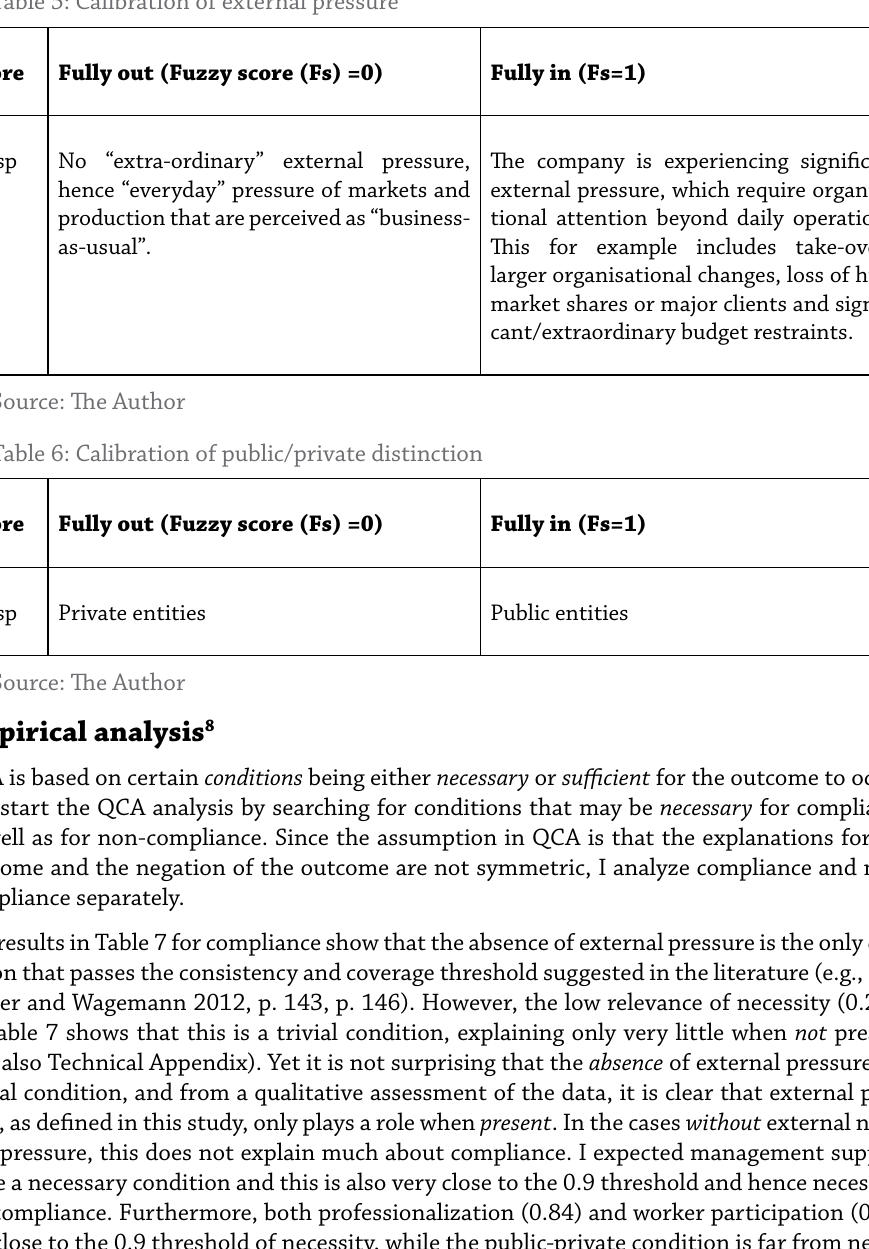
Crisp No “extra-ordinary” external pressure, hence “everyday” pressure of markets and production that are perceived as “business- as-usual”.